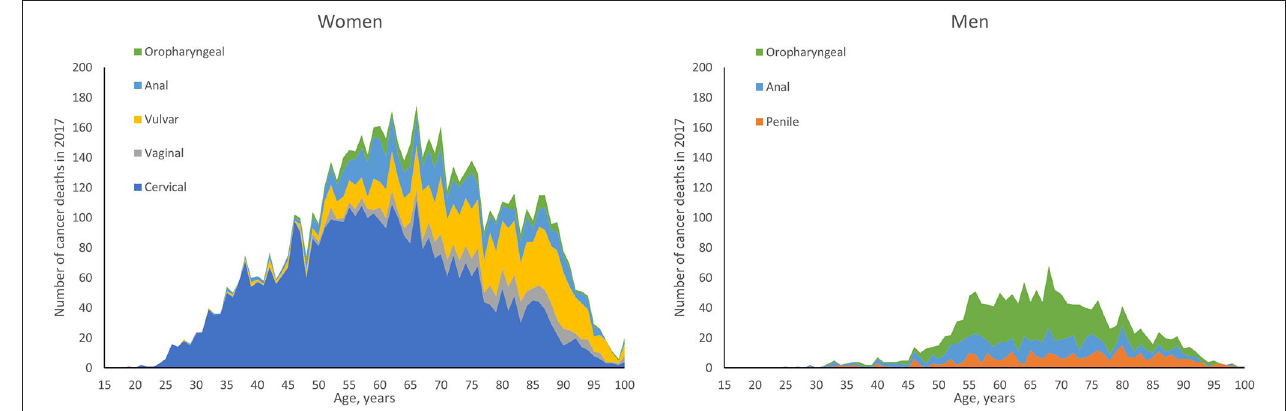
FIGURE 1 | Cancer deaths by age and sex in the United States in 2017: HPV-associated cancers. HPV, human papillomavirus.